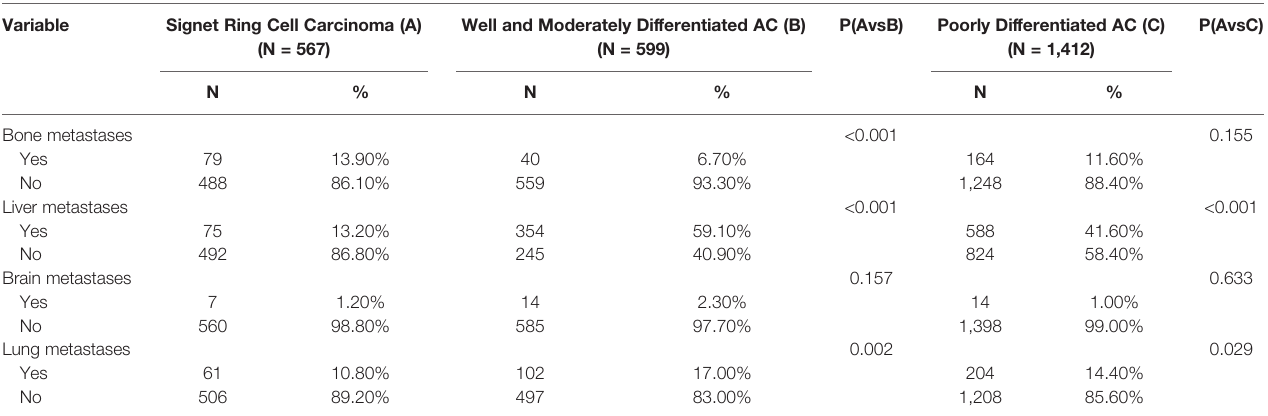
TABLE 3 | Metastasis sites for different subtypes of gastric